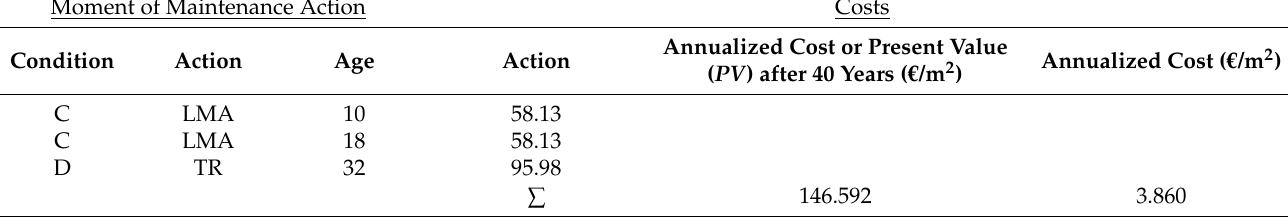
Table 7. Annualized cost of maintenance for the second maintenance strategy (MS2), considering a time horizon of 40